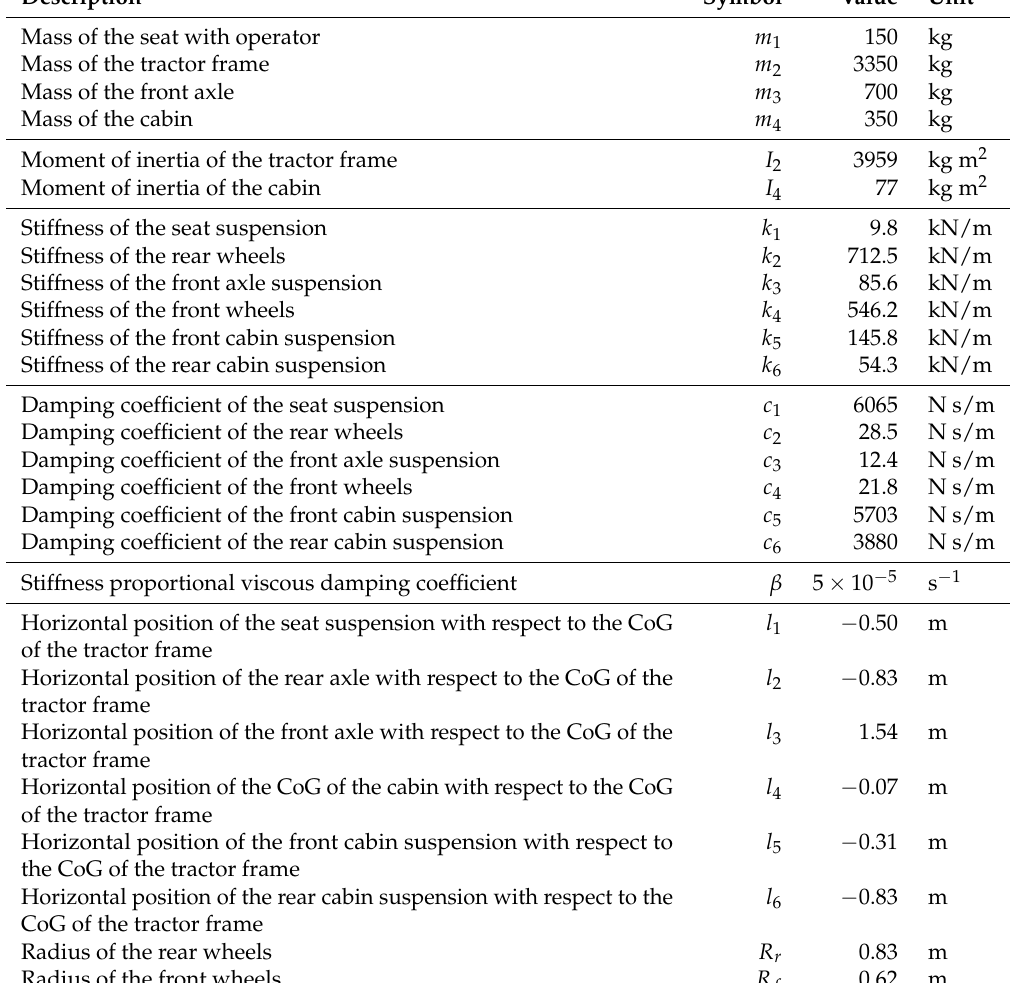
Table 1. Numerical parameters of the 6-DoFs